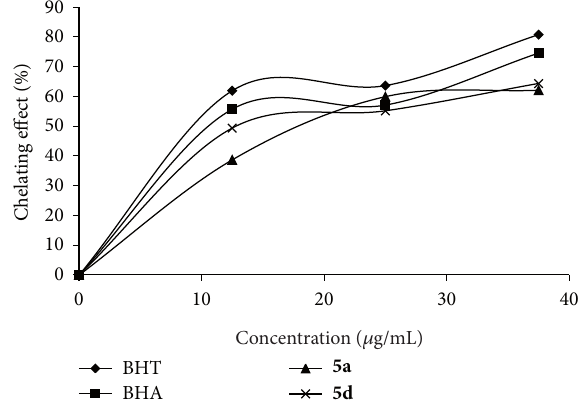
F 3: Metal chelating effect of different amount of the com- pounds 5a and 5d , BHT, and BHA on ferrous